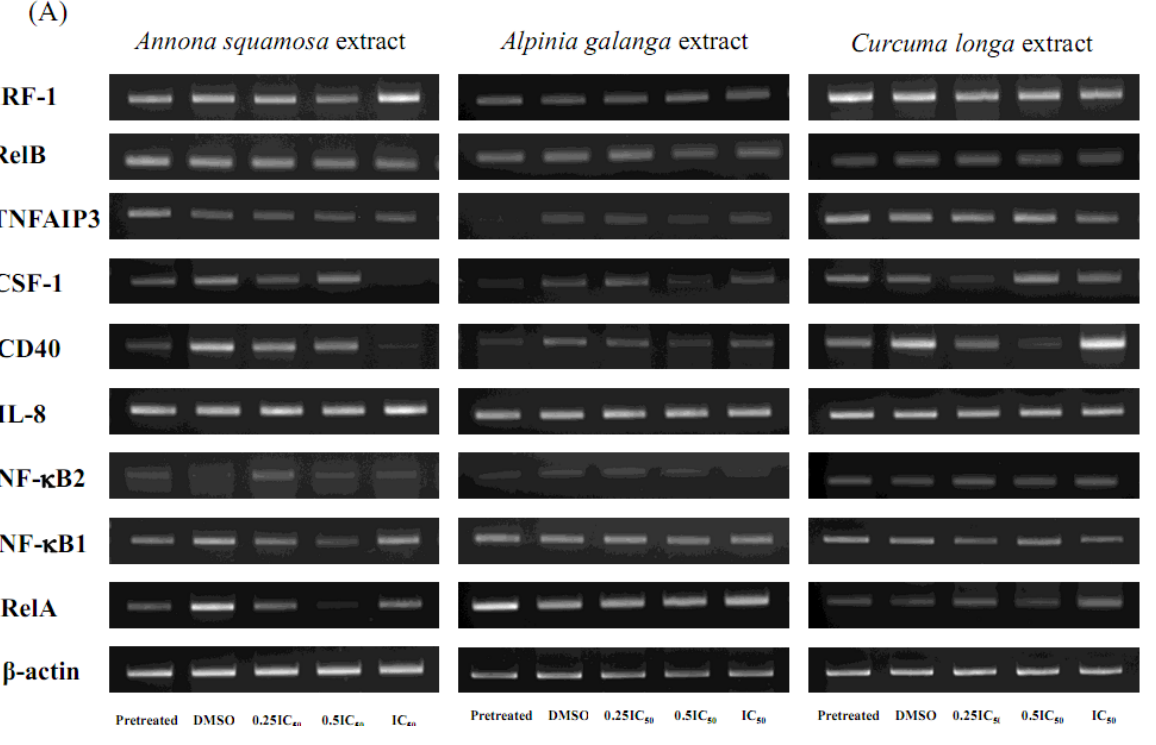
Figure 1. The effect of Thai medicinal herb extracts on the expression of mRNA transcripts of NF- κ B signaling network biomarkers in HaCaT cells pretreated for 24 h with both proinflammatory cytokines (TNF α and IFN γ ) and treated for 48 h with increasing concentrations of each herbal extract